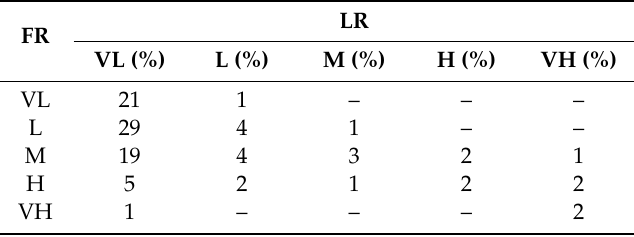
Figure 4. Coverage percentages of landslide susceptibility categories. Table 3. Coverage cross-comparison for the landslide susceptibility categories between both the FR and LR models.